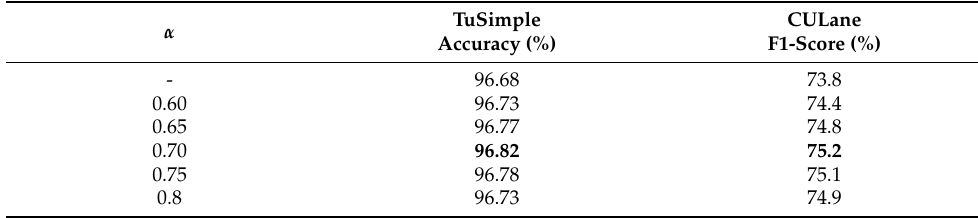
Table 5. The testing results of different α